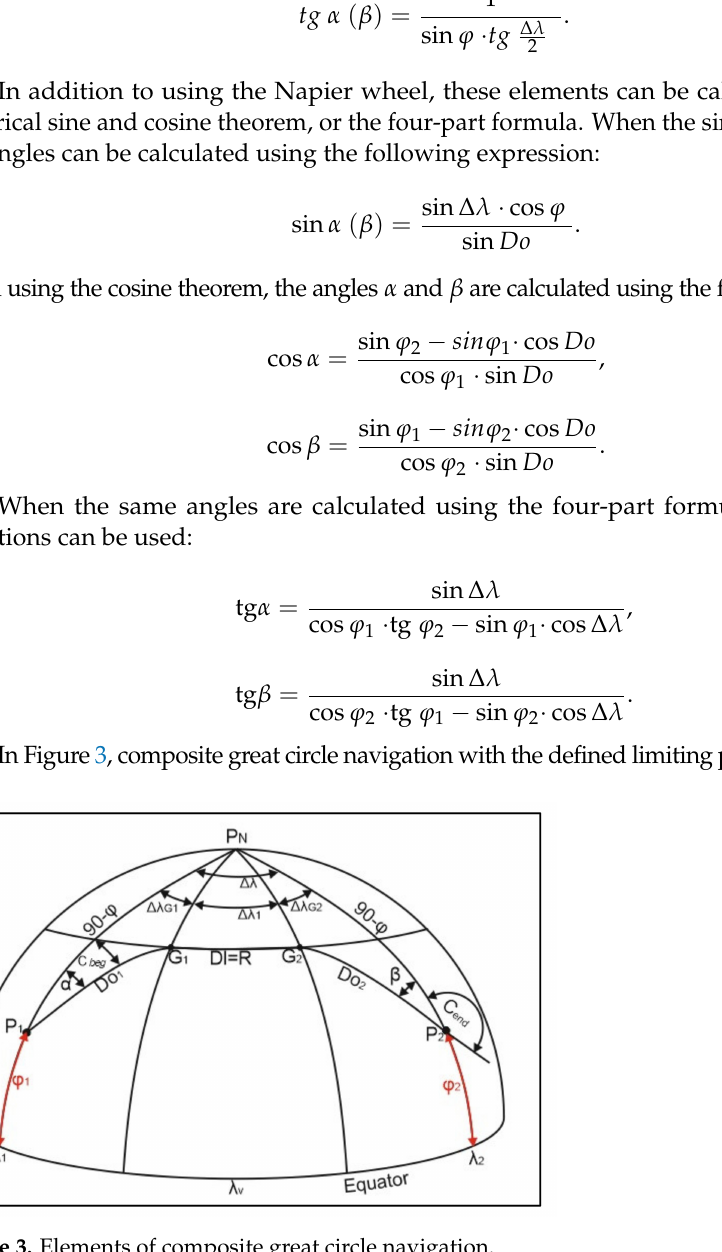
Figure 3. Elements of composite great circle